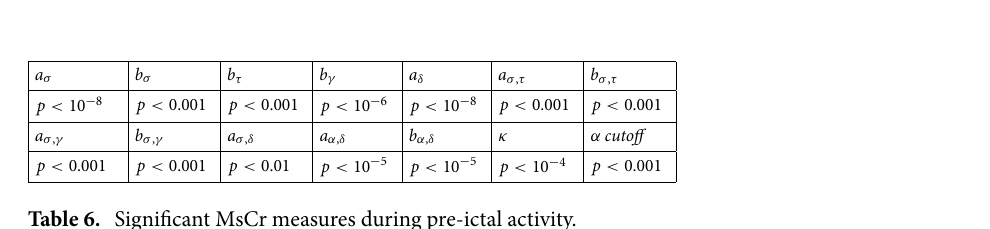
Table 6. Significant MsCr measures during pre-ictal